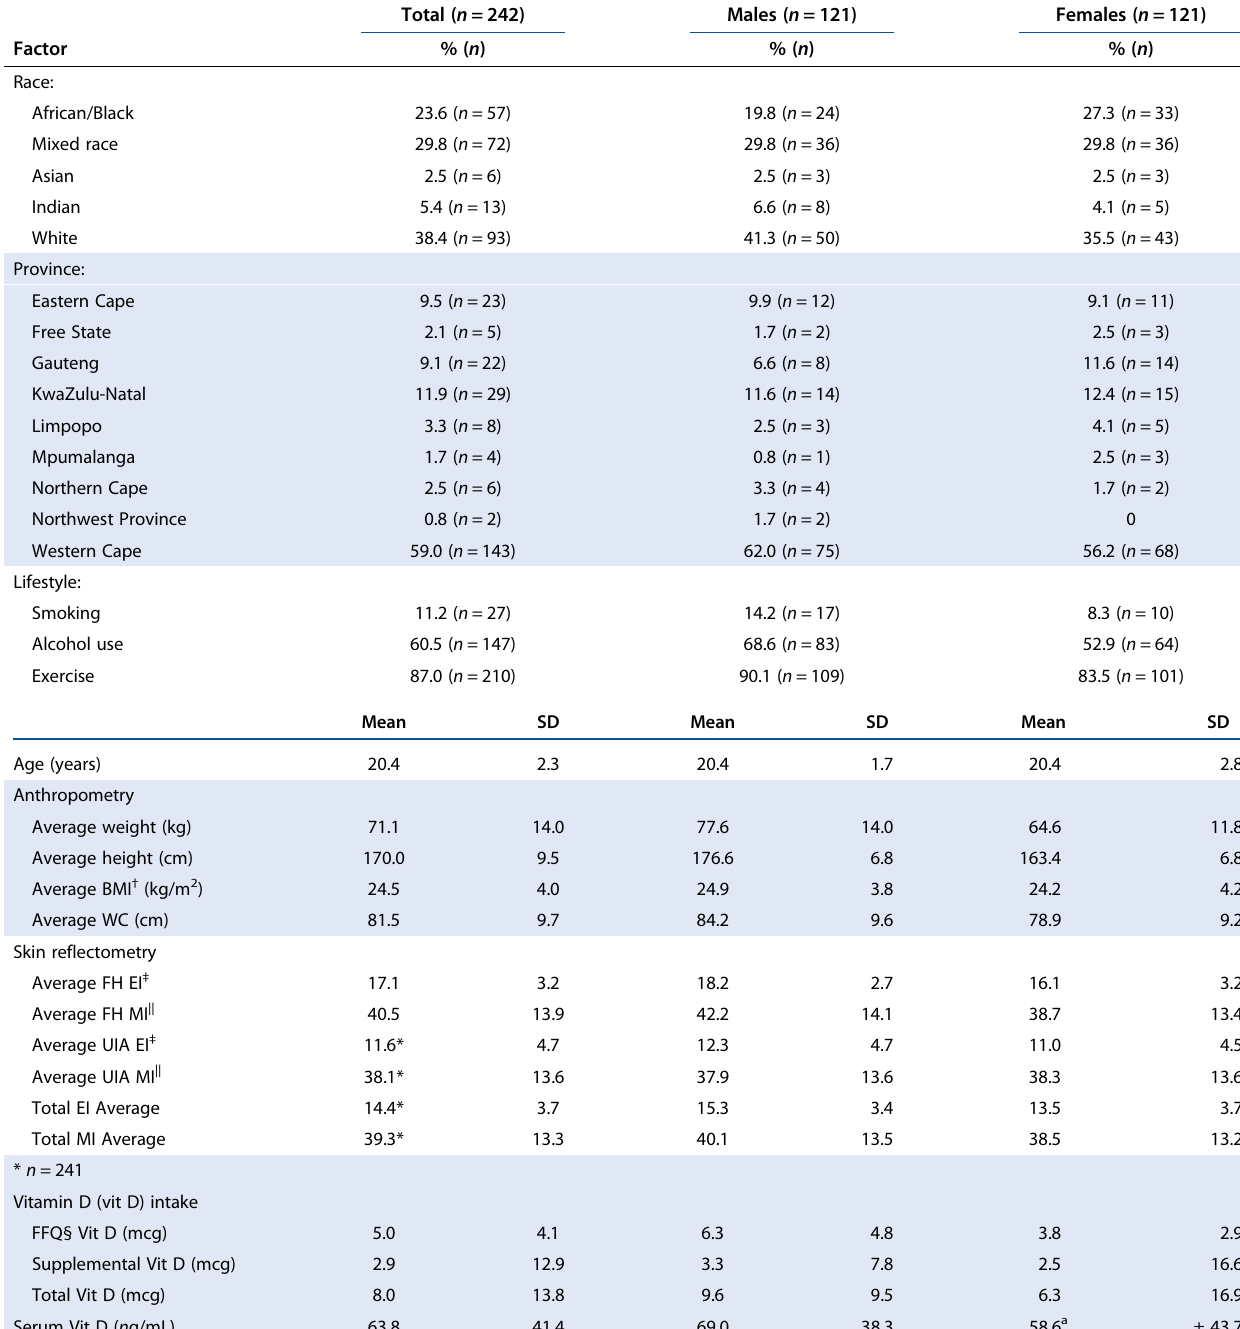
Table 2: Participant demographics and descriptive statistics: winter phase